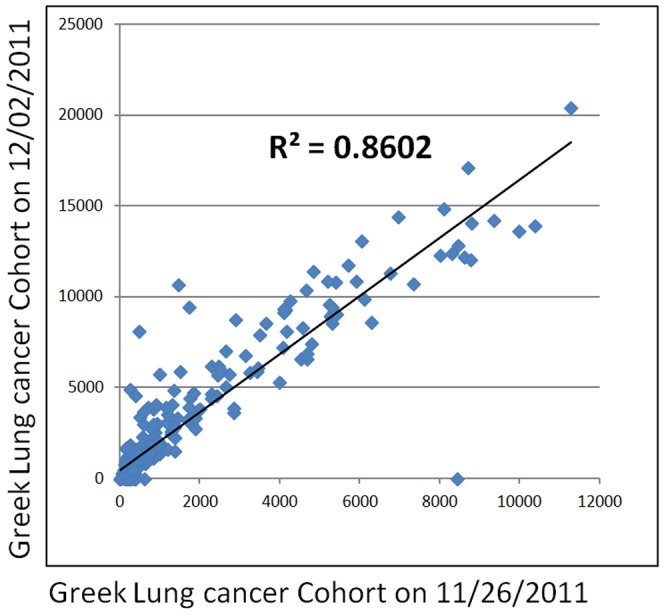
Inter-experiment reproducibility of SOX2 AQUA scores between two serial sections of the tissue microarray.